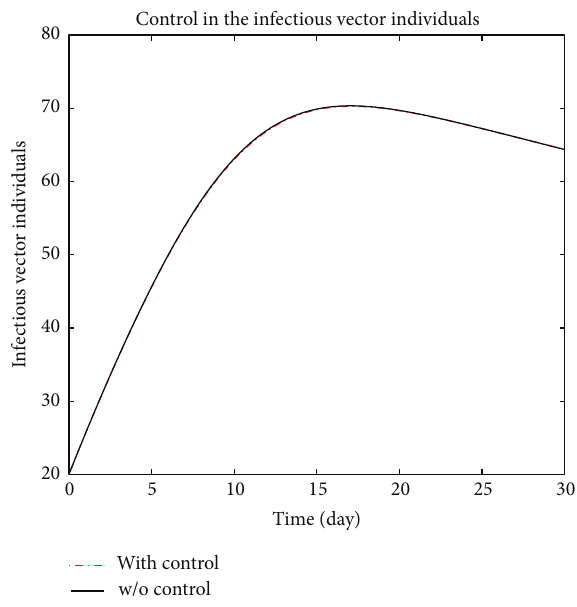
Figure 12: Plot of the number of infected vectors with and without control, 𝑢 1 ̸=0 , 𝑢 2 = 0